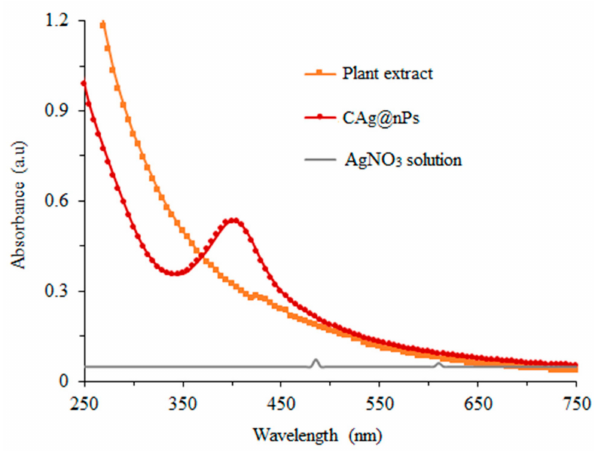
Figure 4. UV-Vis spectra of plant extract, AgNO 3 solution and CAg-nPs at room